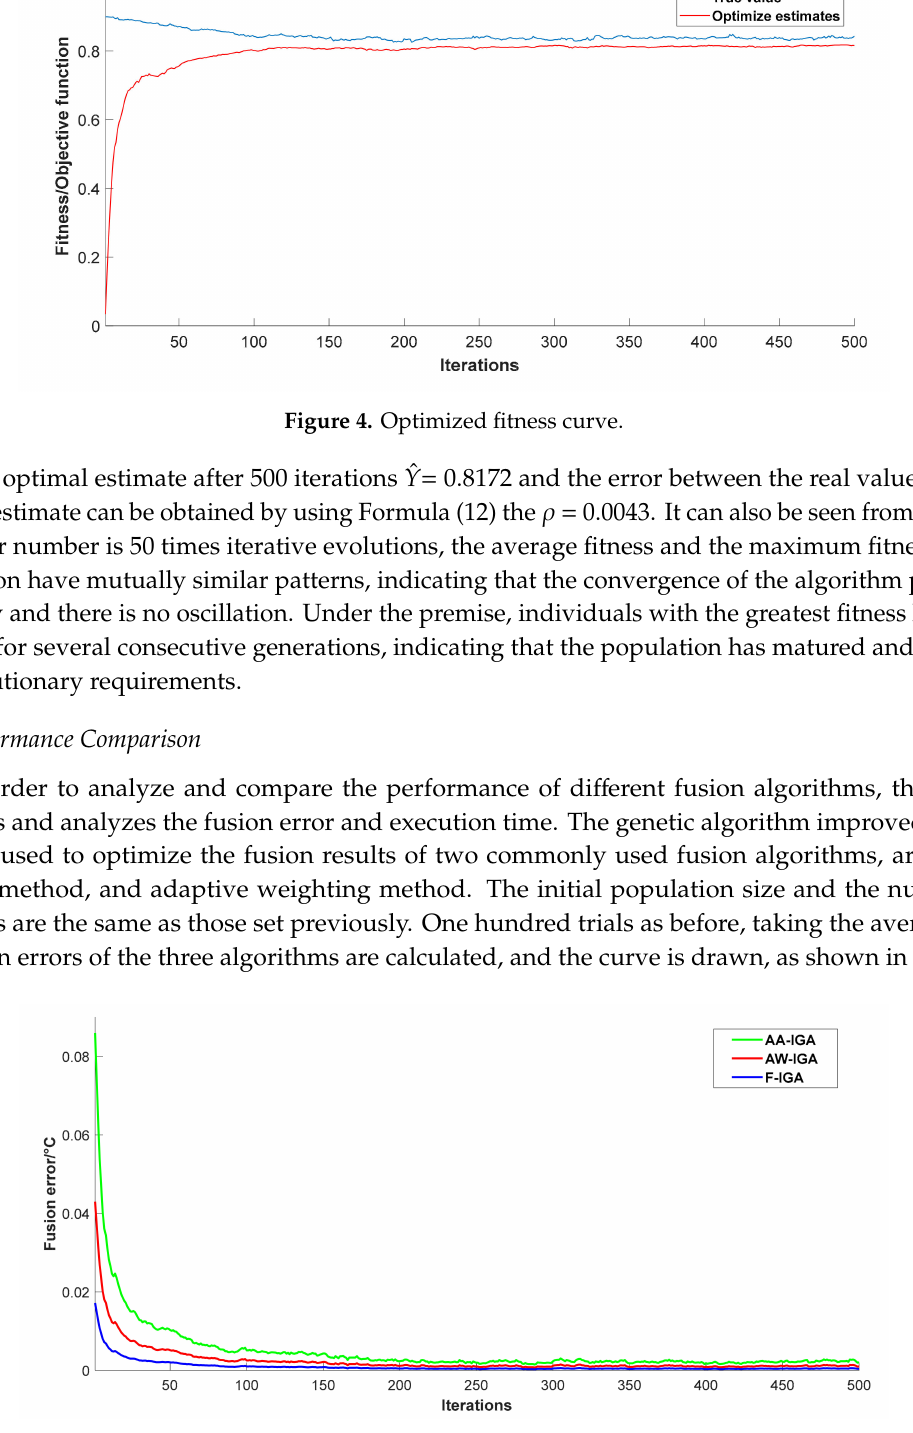
Figure 5. Fusion error curve obtained by three